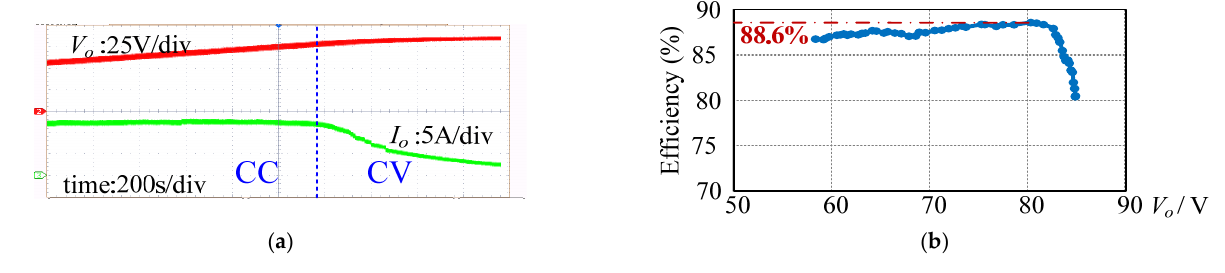
Figure 18. ( a ) Charging curves for closed-loop control and ( b ) corresponding efficiencies.